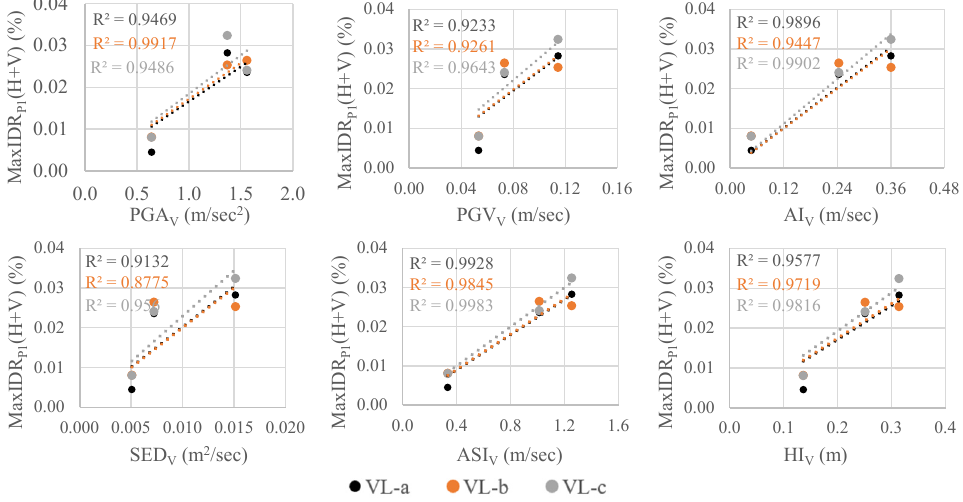
Figure 18. Correlations between the GMPs of the V components (GMP V ) and the maximum IDR obtained on masonry pier P1 from the simultaneous application of the H and V components, maxIDR P1 (H + V). In each image, with the sole exception of the PGA V plot, from left to right, earthquakes #3, #1, and #2; in the PGA V plot ( top left ), from left to right, earthquakes #3, #2, and #1.